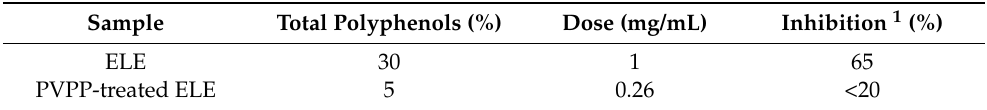
Table 1. Total polyphenol content and inhibitory effects of ELE on fructose absorption. Sample Total Polyphenols (%) Dose